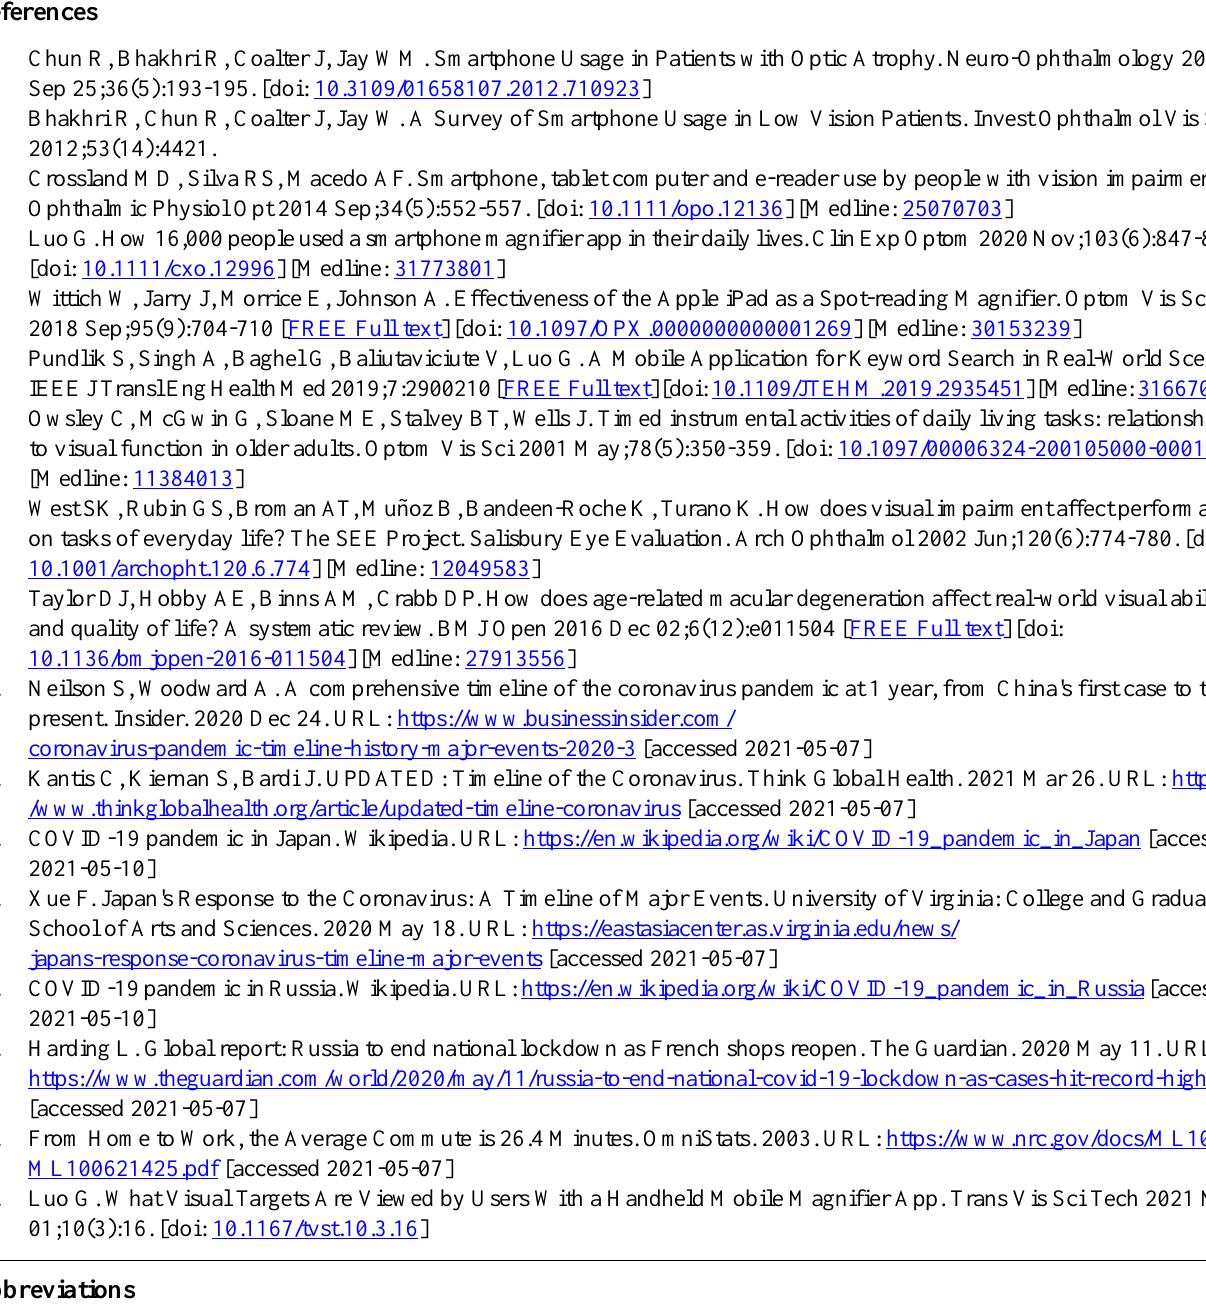
ARIMA: autoregressive integrated moving